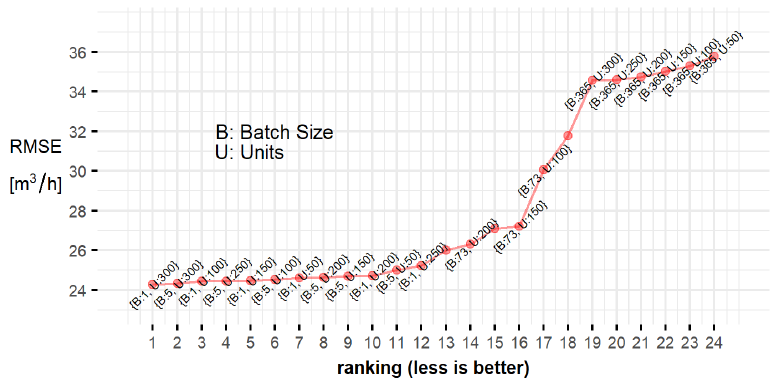
Figure 5. Ranking of hyperparameters combinations. Each point represents the average of the twenty RMSE